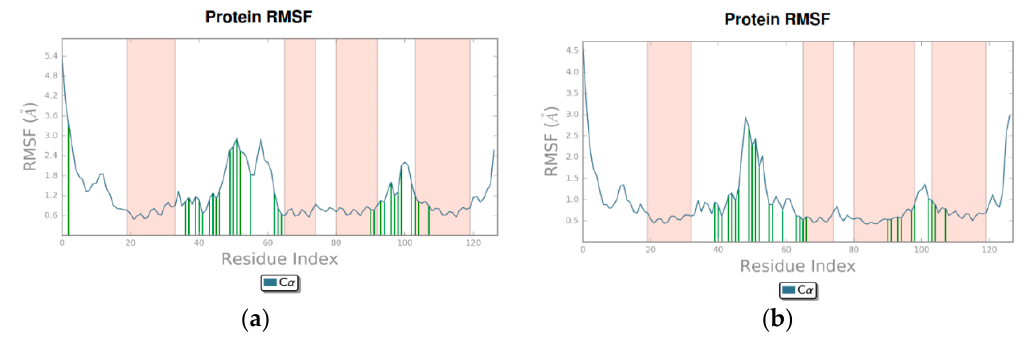
Figure 6. Root-mean-square fluctuation (RMSF) values based on alpha carbons; ligand contacts are presented in green, and protein helices in orange. ( a ) Amentoflavone; ( b ) Fisetin.